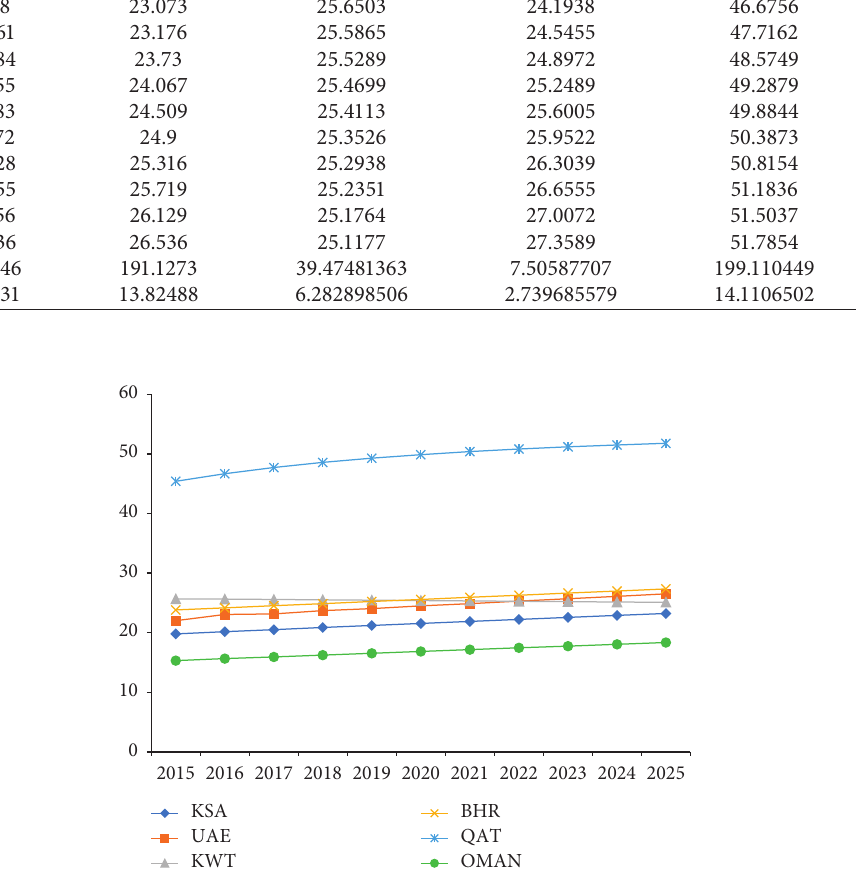
Figure 2: Predicted value of CO 2 emissions (metric tons per capita) using the ARIMA (1,1,1) model.